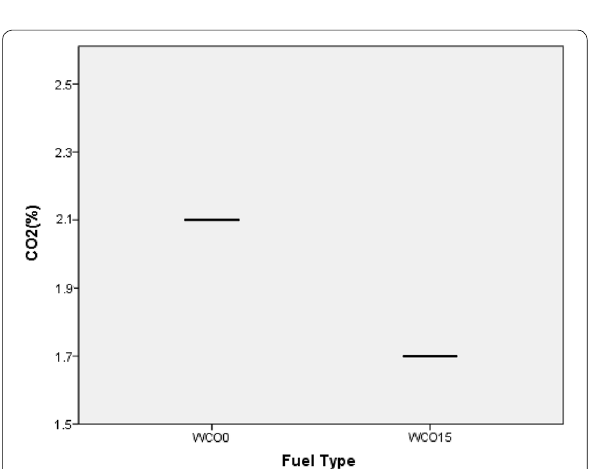
Fig. 2 Box plot diagrams of driving and exhaust characteristics